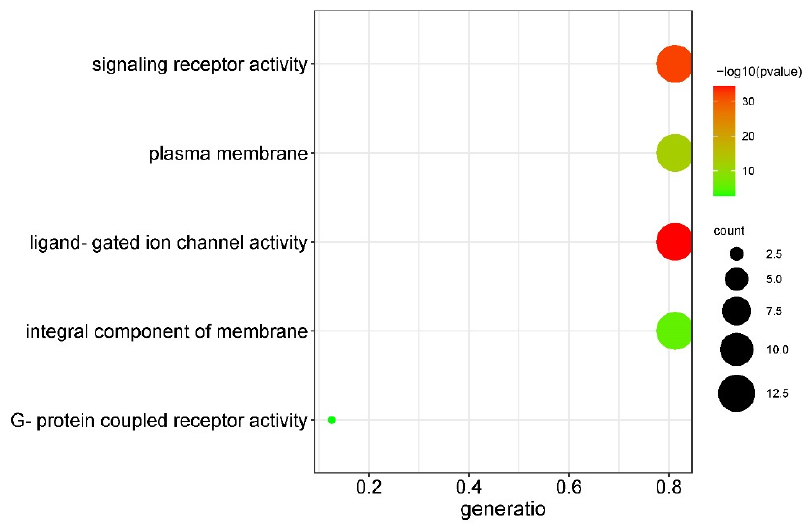
Figure 4. GO enrichment analysis of BraGLRs. The size of the dot bubble represents the number of genes on that GO term.